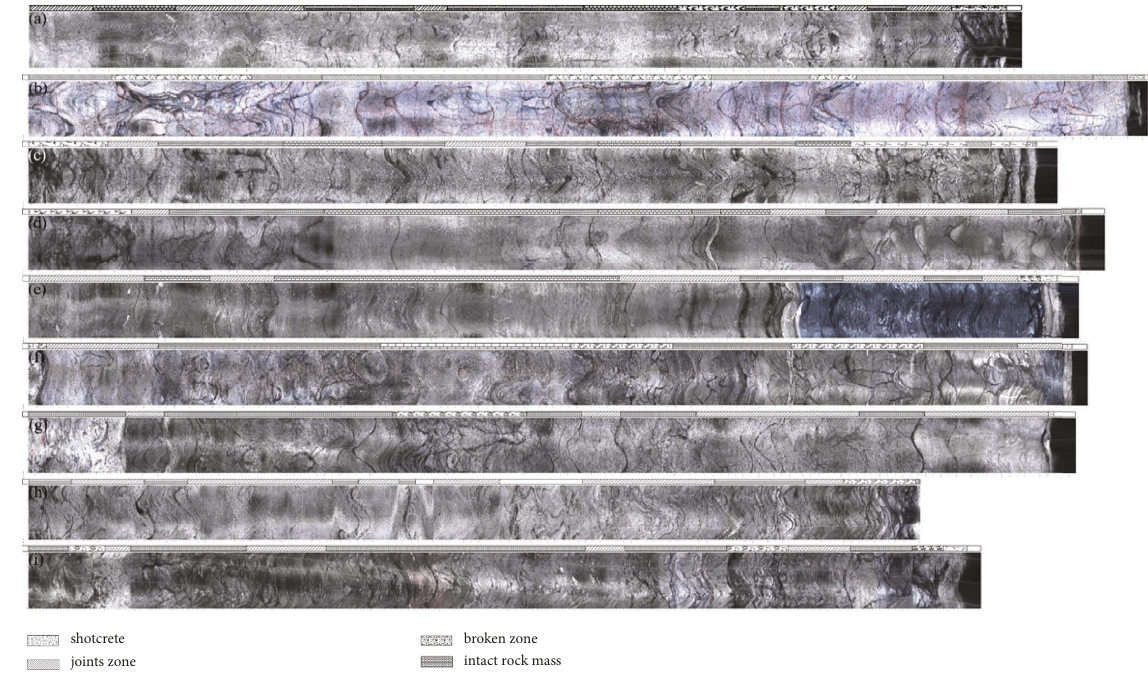
Figure 9: Image of IV grade surrounding rock of a vertical hole (a) Hole No.1. (b) Hole No. 2. (c) Hole No. 4. (d) Hole No. 9. (e) Hole No.10. (f) Hole No. 11. (g) Hole No. 13. (h) Hole No. 16. (i) Hole No. 17.